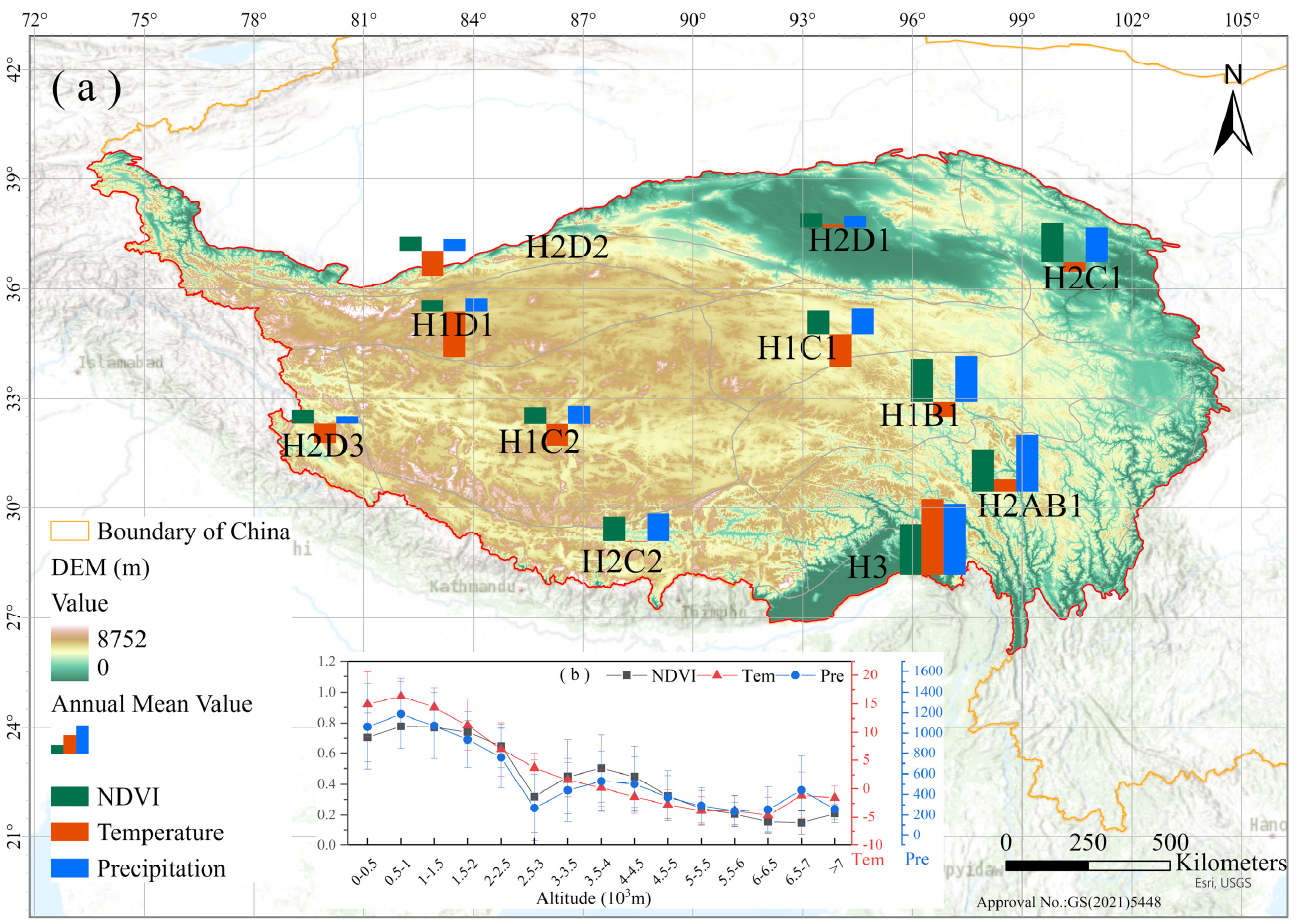
Figure 1. Map of study area and meteorological station locations, the ecological climate zones proposed by Zheng Du, and bar chart of mean NDVI, temperature, and precipitation values ( a ). Mean NDVI, temperature, and precipitation values at different altitudes ( b